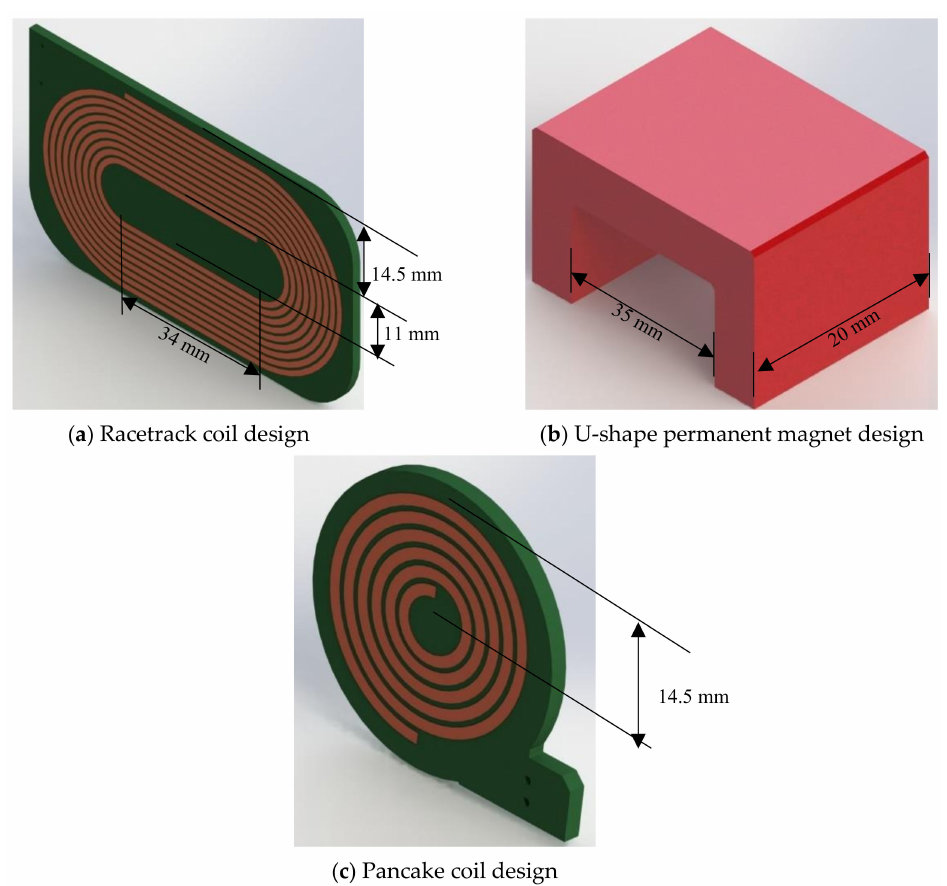
Figure 4. Graphical illustration of ( a ) the racetrack coil, ( b ) the horseshoe permanent magnet and ( c ) the pancake